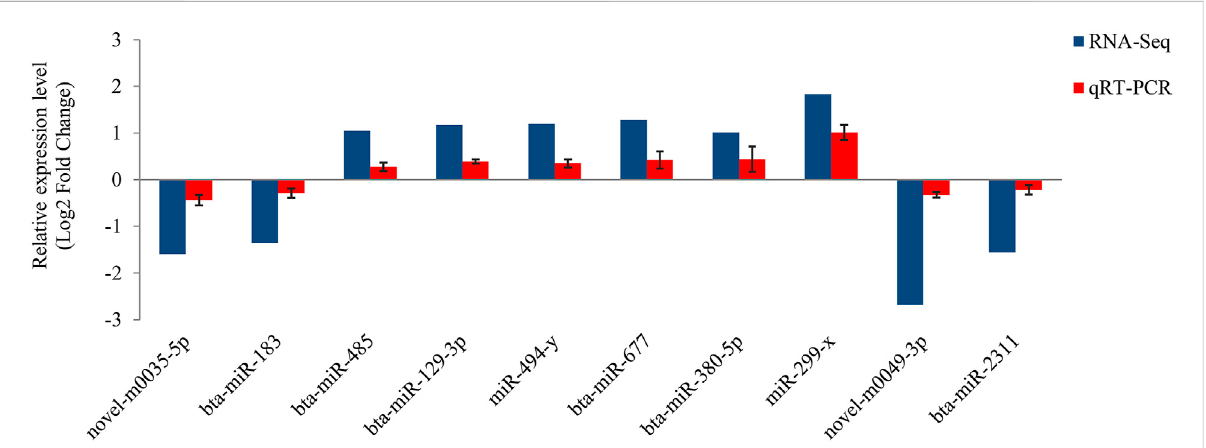
FIGURE 4 Validation of the miRNA-Seq results. The qRT-PCR validation was performed on 10 DE-miRNAs. These data show the mean ± SD for three replicates. Error bars indicate the standard